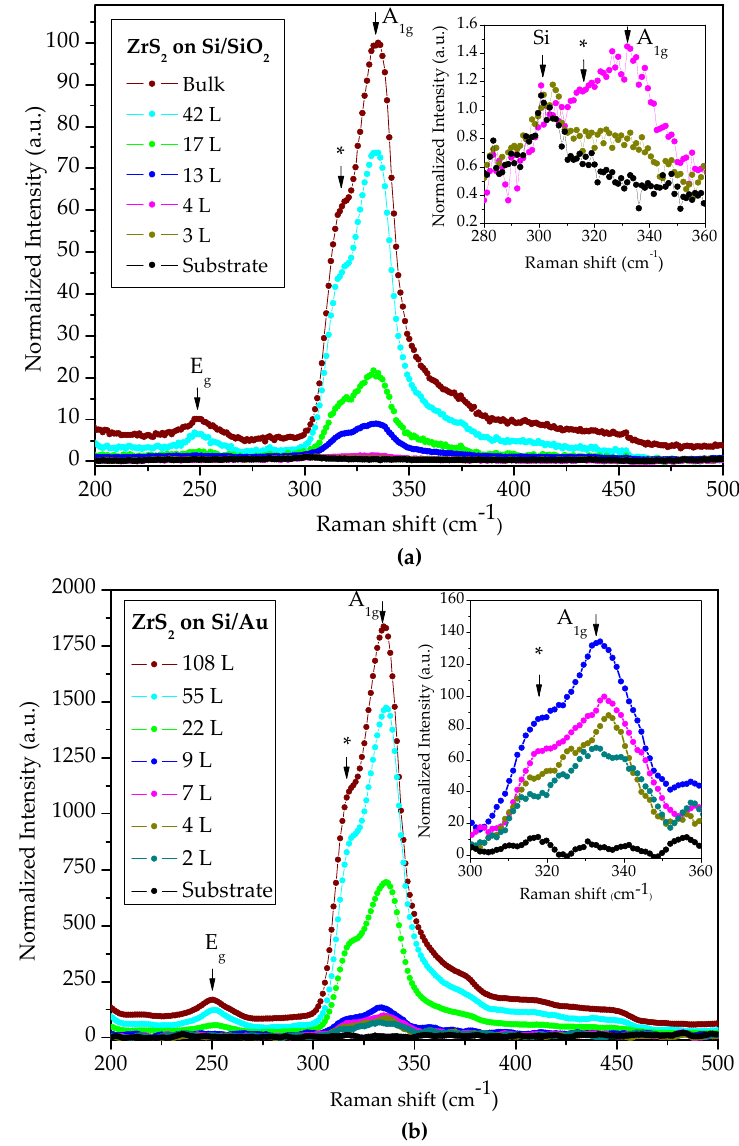
Figure 3. Thickness dependence of the Raman spectra for ZrS 2 ( λ = 532 nm) ( a ) on a silicon substrate with 285 nm of SiO 2 and ( b ) on a silicon substrate covered with Ta (3 nm)/Au (30 nm). Inset: zoom of Raman spectra in the characteristic peak for thin layers. The intensity has been normalized to the height of the silicon phonon peak. The Raman modes A 1g and E g are labeled. The shoulder marked with “*” is attributed to a broadening of the A 1g peak due to non-harmonic effects.